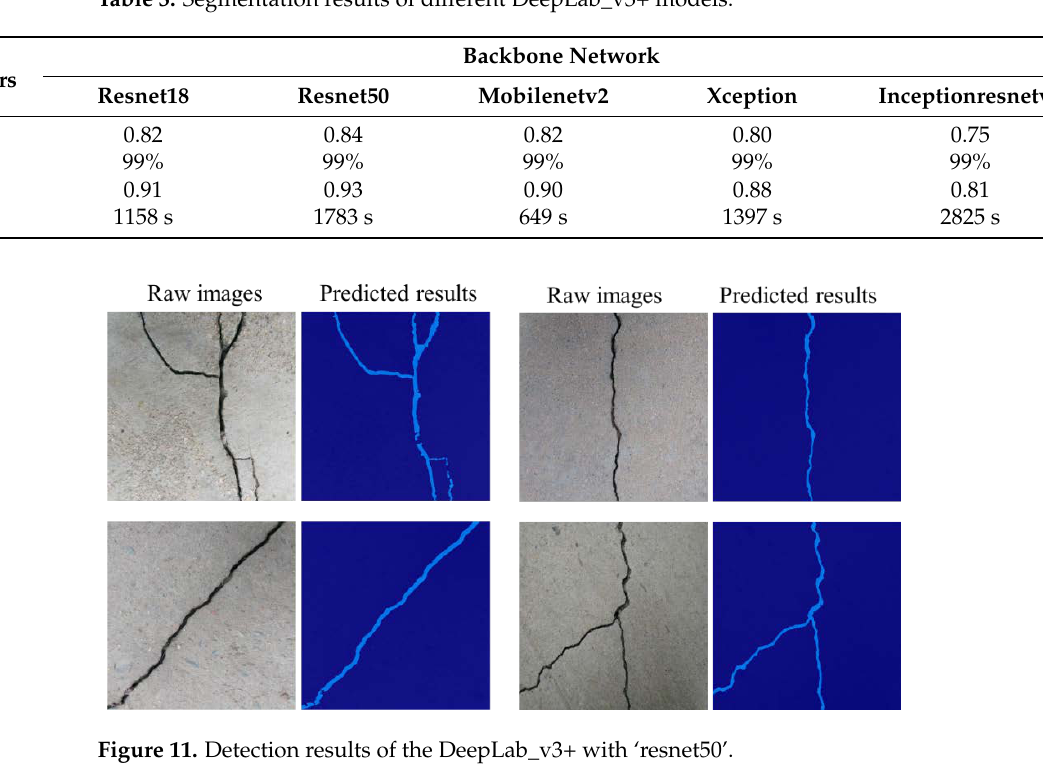
Table 3. Segmentation results of different DeepLab_v3+ models.